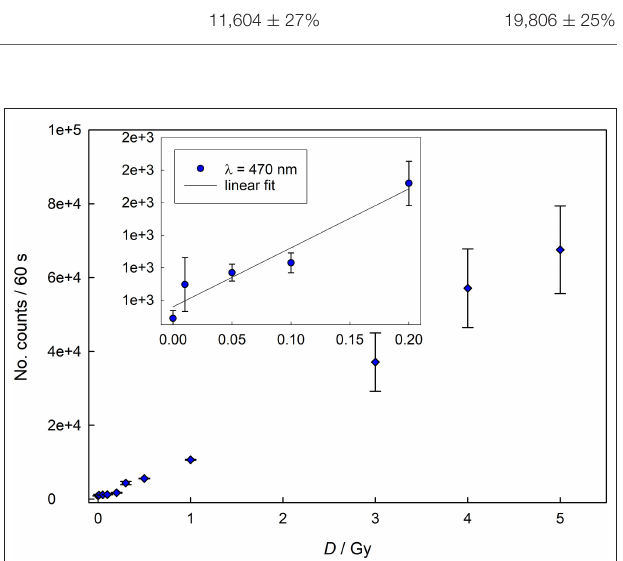
FIGURE 1 | Dose response for blue light (470nm) stimulation (data acquired with Reader